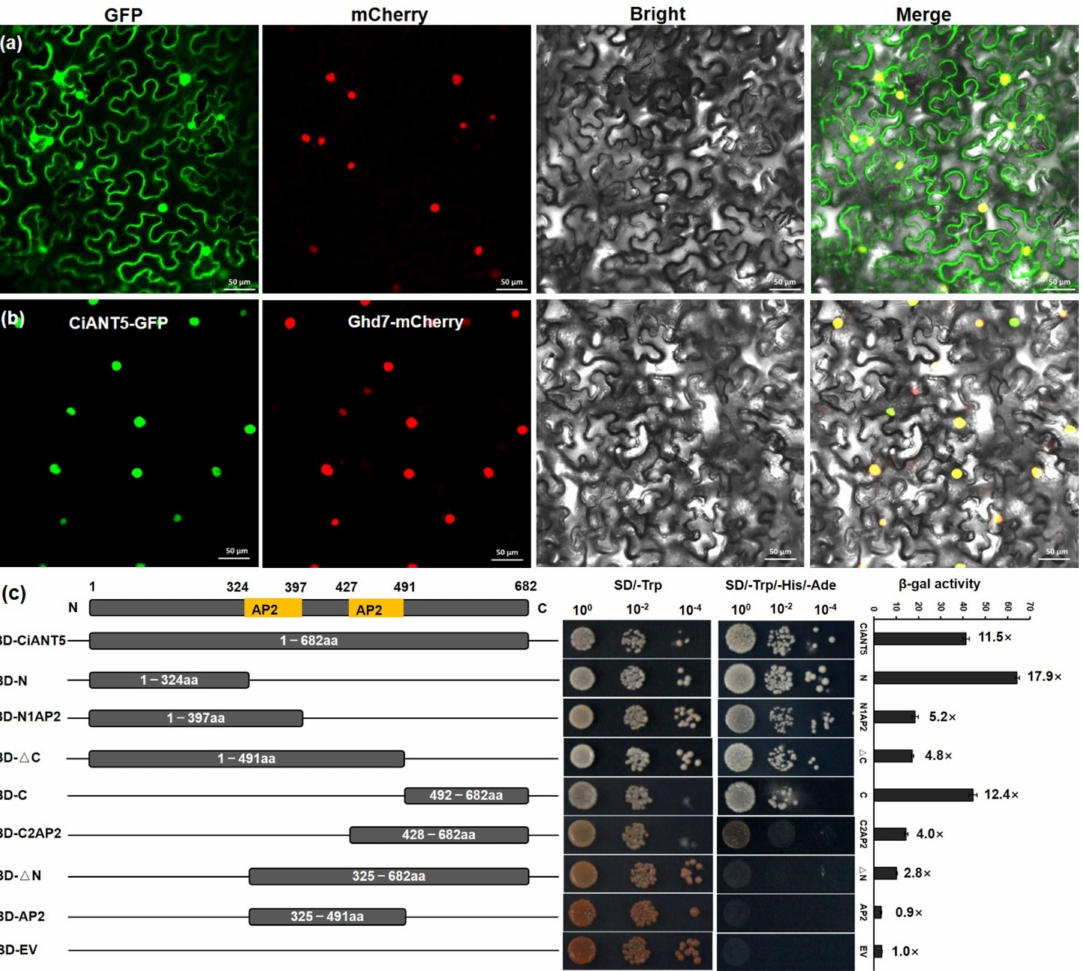
Figure 6. The subcellular and transcriptional analysis of CiANT5. ( a ) GFP fluorescence signal of GFP protein. ( b ) GFP fluorescence signal of the CiANT5-GFP fused protein. Ghd7-mCherry was used as nuclear maker. Bar = 50 µ m. ( c ) The transcriptional activity analysis of CiANT5 in yeast AH109 strain. The left diagram shows different constructions used for transcriptional assay. BD, GAL4-DNA binding domain; EV, empty pGBKT7 vector used as a negative control. The middle panel displayed different constructions cultured on selective medium SD/-Trp and SD/-Trp/-His/-Ade. The right panel displays β -galactosidase ( β -gal) activity in the various constructions. Mean values ± SE were calculated from three